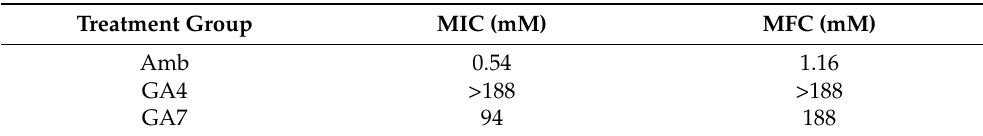
Table 2. Minimum inhibitory concentration (MIC) and minimum fungicidal concentration (MFC) values of amphotericin B (Amb), gibberellin A4 (GA4), and gibberellin A7 (GA7) against C. albicans MYA 2876.